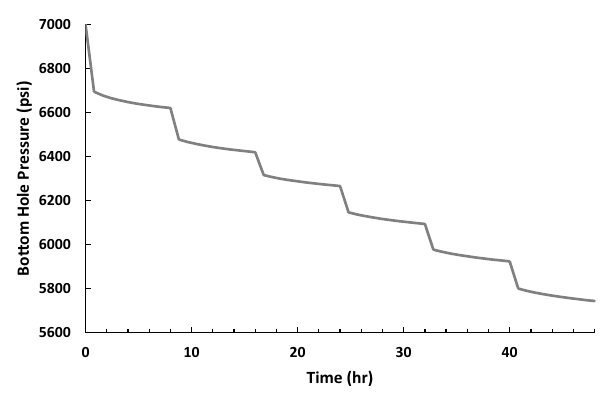
Fig. 5 Bottom hole pressure vs. time in modified backpressure test at well #1